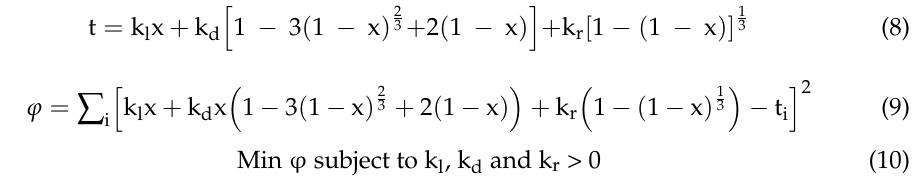
Table 9. Correlation coefficient values of shrinking core kinetic models for chalcopyrite.